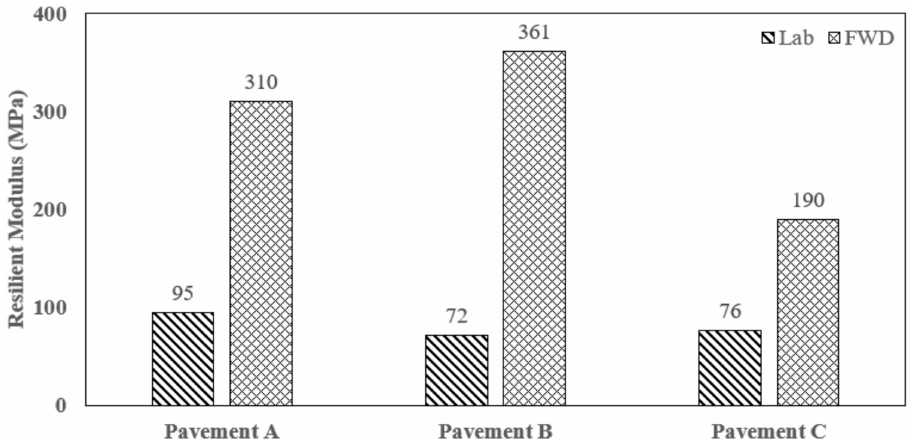
Figure 6. Relationship between Laboratory and Backcalculated FWD M R . Table 4. Developed C factors for Coarse and Fine-Grained Soil Samples. Moisture